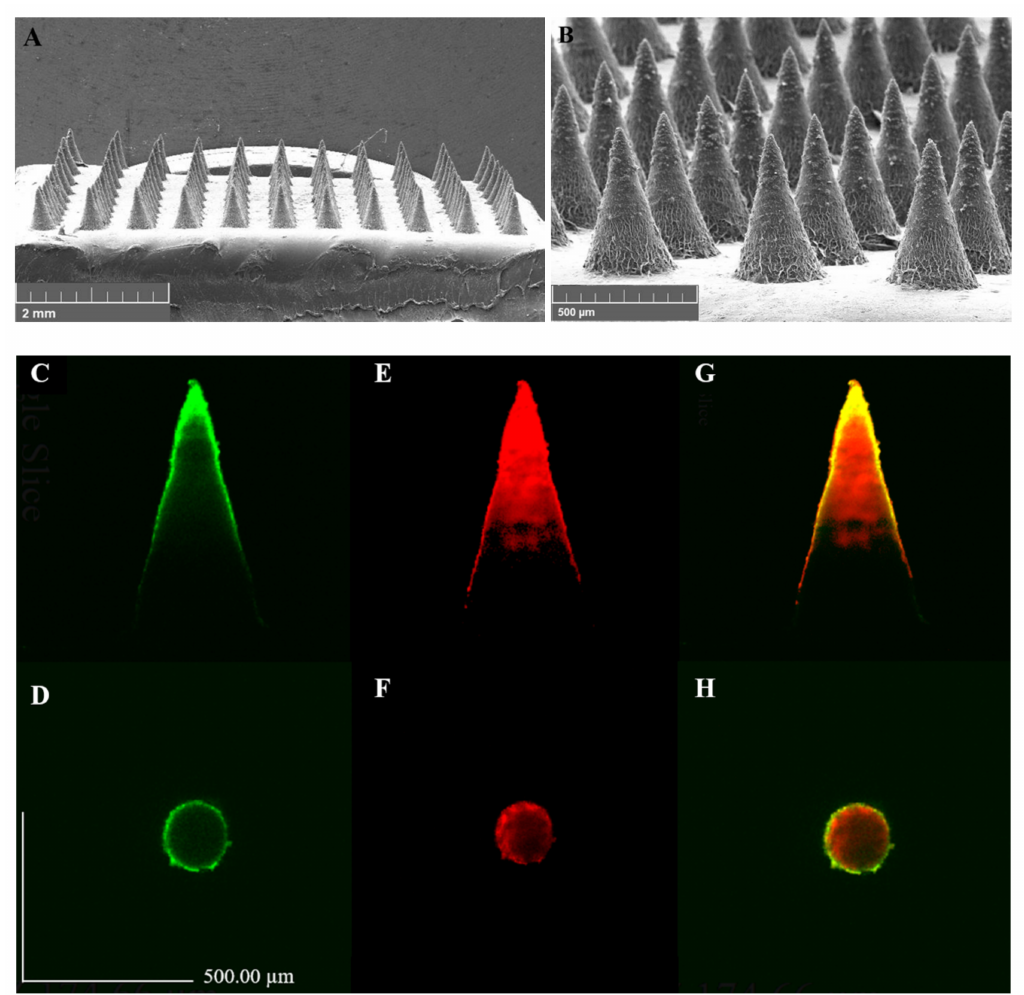
Figure 4. Appearance of FLUZ-MEs-loaded two-layered dissolving MNs: SEM images (magnification ( A ) 30 × and ( B ) 130 × ) and confocal images in side view and top view of ( C , D ) loaded FS (green color); ( E , F ) loaded rhodamine b (red color); and ( G , H ) both first layer FS and second layer rhodamine